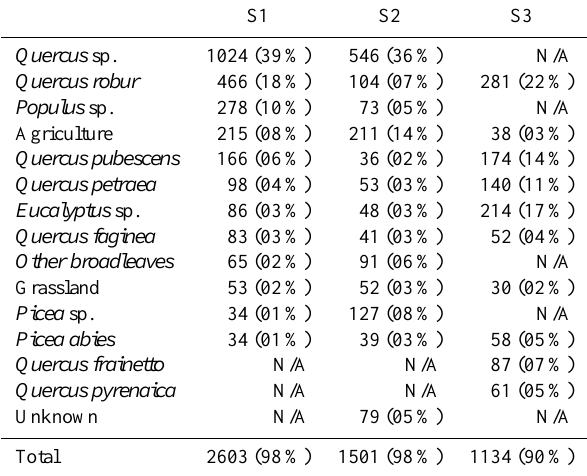
Table 2. Top emitters of isoprene (based on annual data, original countries), selected so that at least the ten most important emitters for each inventory is shown. Values in Gg yr − 1 .